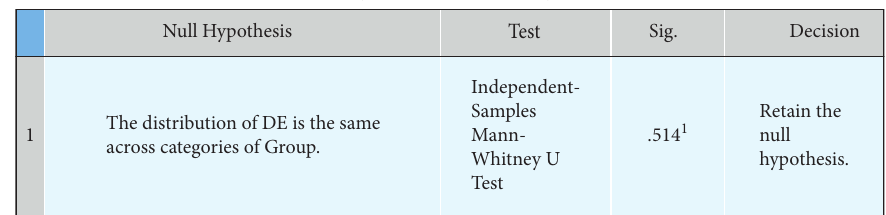
Figure 12: Comparing DM3 with SCGA using the Mann–Whitney U test through IBM SPSS Statistics